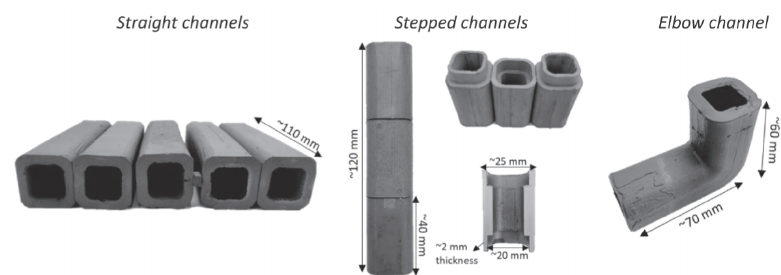
Figure 13. SIC-sandwich prototypes produced by gel casting at lab-scale. Reprinted from Ref.